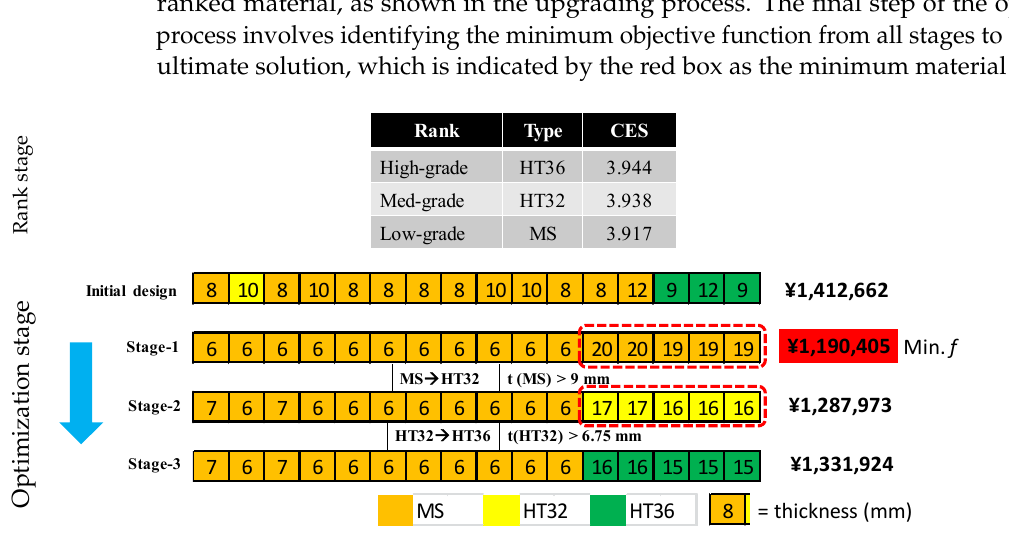
Figure 7. Process of material change.